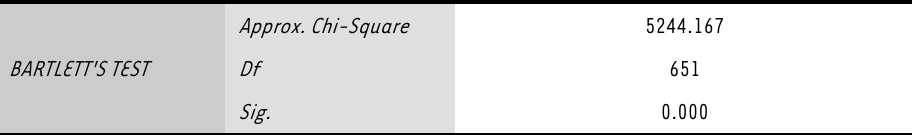
TABLE 2: Barlett’s test for item validity